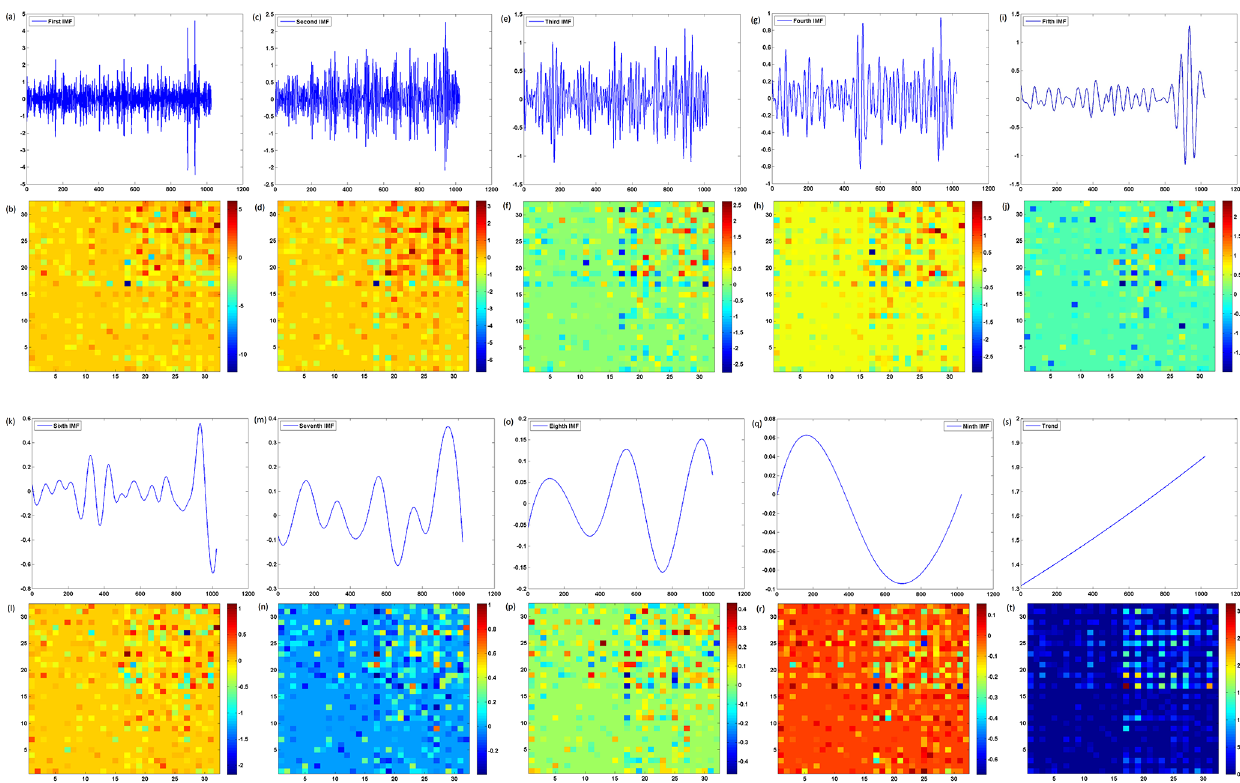
Figure 3. Ensemble empirical mode decomposition of the time series. (a–i) Intrinsic mode functions from the first to the ninth; (j) intrinsic mode function of the trend; (k–s) state-to-state relative weight matrices for the intrinsic mode functions from the first to the ninth; (t) state- to-state relative weight matrix of the trend. Time steps and the corresponding calendar dates: 0 (cid:49)t – 1 January 1982; 200 (cid:49)t – 6 December 1986; 400 (cid:49)t – 10 November 1991; 600 (cid:49)t – 14 October 1996; 800 (cid:49)t – 18 September 2001; 1000 (cid:49)t – 23 August 2006; 1024 (cid:49)t – 27 March 2007. We provide this information here to avoid any cluttering of the